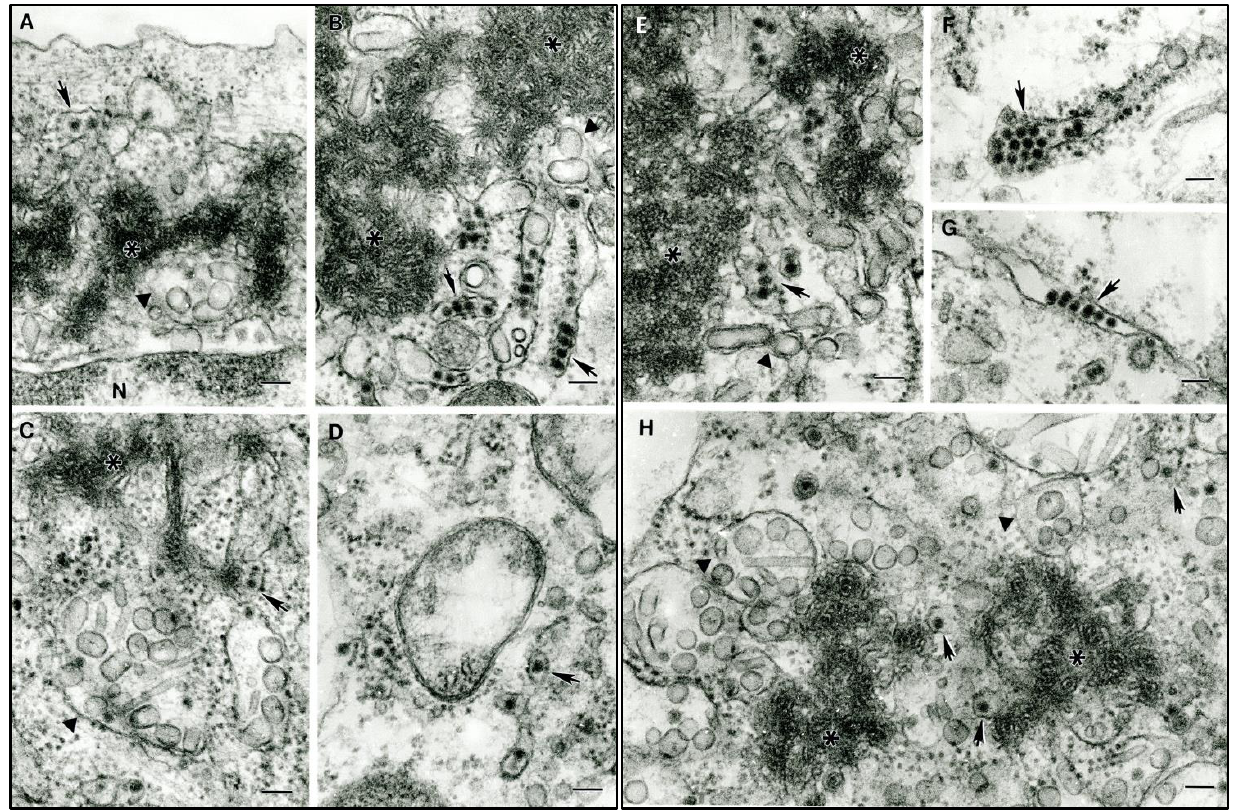
Figure 2. Ultrastructure of ILHV in Vero and C6/36 cells. Arrows show virus particles inside gran- ular endoplasmic reticulum cisterns. Asterisks show convoluted membranes, and solid triangles show smooth membrane structures (SMS). ( A ) Original strain in Vero cells. ( B ) H 2944 strain in Vero cells. ( C , D ) H 2944 strain in C6/36 cells. ( E – G ) ZPC 804 strain in Vero cells. ( H ) ZPC 804 strain in C6/36 cells. Bar—100 nm.